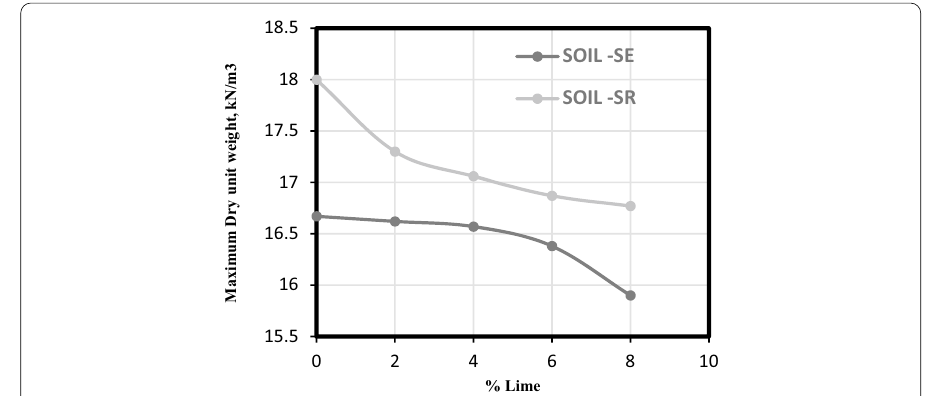
Fig. 5 Maximum dry unit weight of soils SE and SR at different lime content